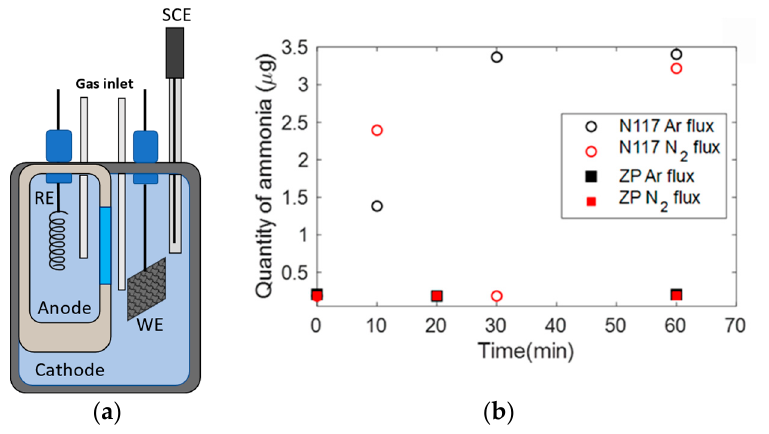
Figure 5. Scheme of the experimental setup for the NRR ( a ). Ammonia quantity in electrolyte solution in the cathodic chambers under Ar or N 2 flux ( b ).